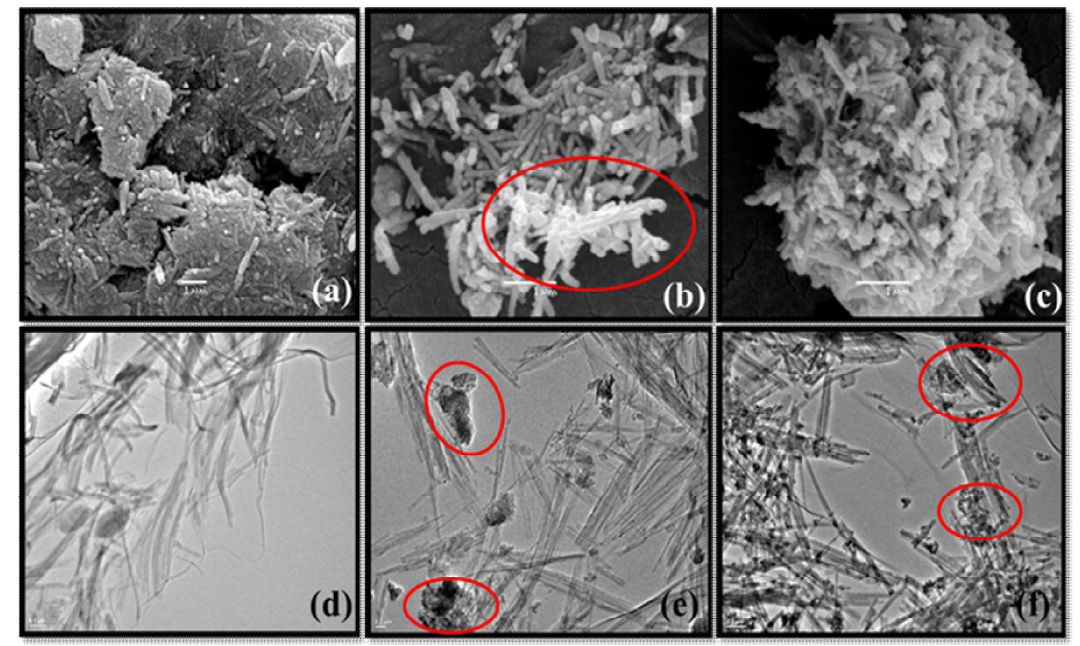
Figure 4. Scanning electron microscopy (SEM) and transmission electron microscopy (TEM) micrographs: ( a , d ) Palygorskite; ( b , e ) TiO 2 –Pal; ( c , f ) ZrO 2 -TiO 2 –Pal.